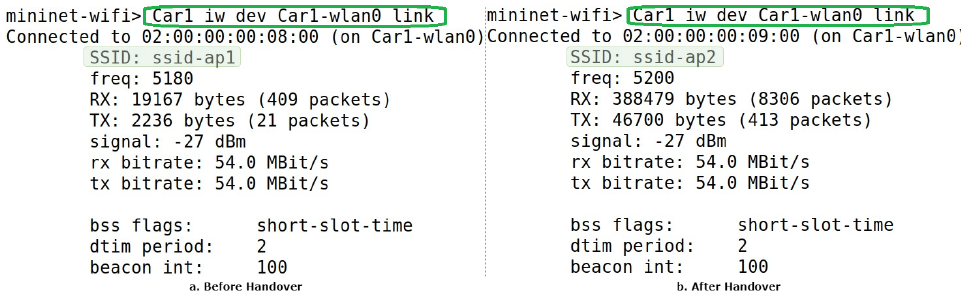
Figure 12. Connected access point for Car1 before and after handover/moving.